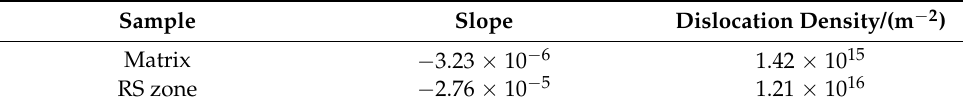
Figure 10. (( ∆ K ) 2 − α )/ K 2 vs. H 2 plot for martensite peaks ( a ) matrix and ( b )RS zone assuming Gaussian and Lorentzian peak broadening, respectively. Table 7. Calculation results of slope and dislocation density.